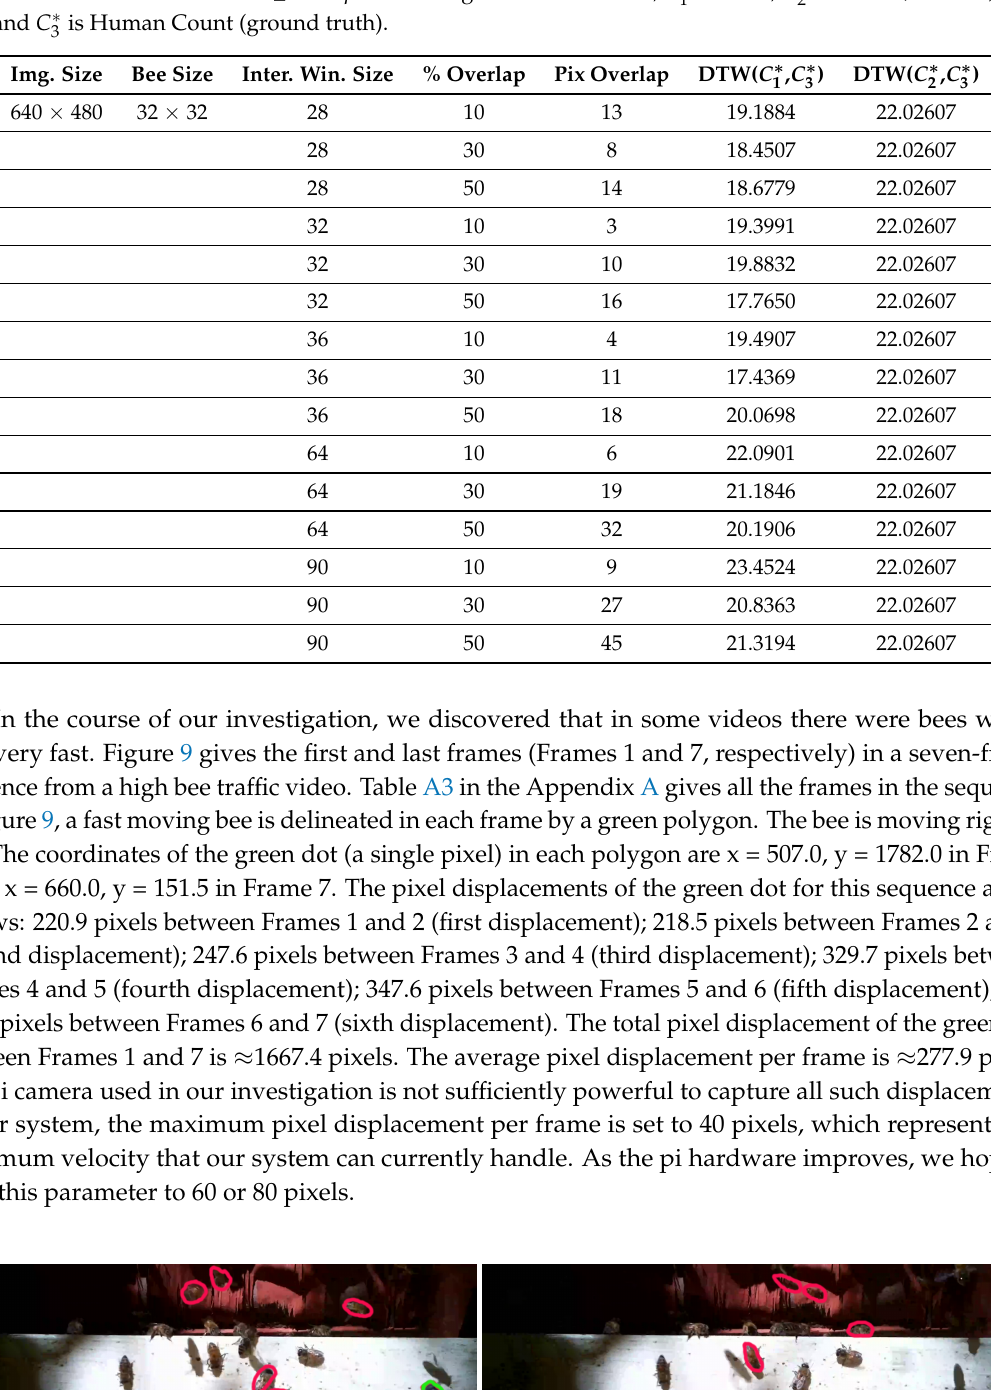
is DPIV; C ∗ is MOG2/VGG16; 2 1